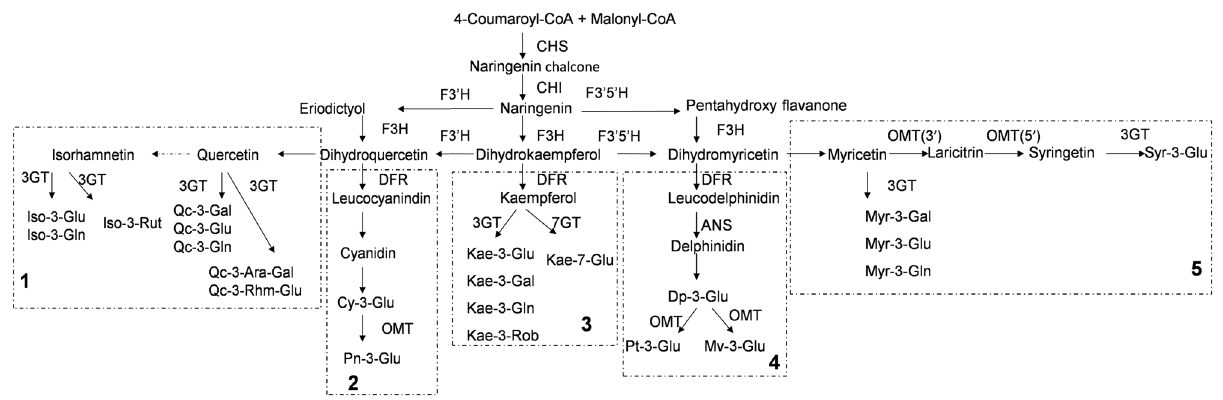
Figure 5. Putative flavonoid biosynthesis pathway in lotus. Notes: Dp: delphinidin; Cy: cyanidin; Pt: petunidin; Pn: peonidin; Mv: malvidin; Myr: myricetin; Qc: quercetin; Kae: kaempferol; Iso: isorhamnetin; Syr: syringetin; Glu: glucoside; Gal: galactoside; Gln: glucuronide; Rob: robinobioside; CHS: chalcone synthase; CHI: chalcone isomerase; F3H: flavonoid 3-hydroxylase; F3 9 H: flavonoid 3 9 -hydroxylase; F3 9 5 9 H: flavonoid 3 9 ,5 9 -hydroxylase; DFR: dihydroflavonol reductase; ANS: anthocyanidin synthase; FLS: flavonol synthase; LDOX: leucoanthocyanidin dioxygenase; GT: flavonoid glycosyltransferase; OMT: O -methyltransferase; CoA: acethl coenzyme A.